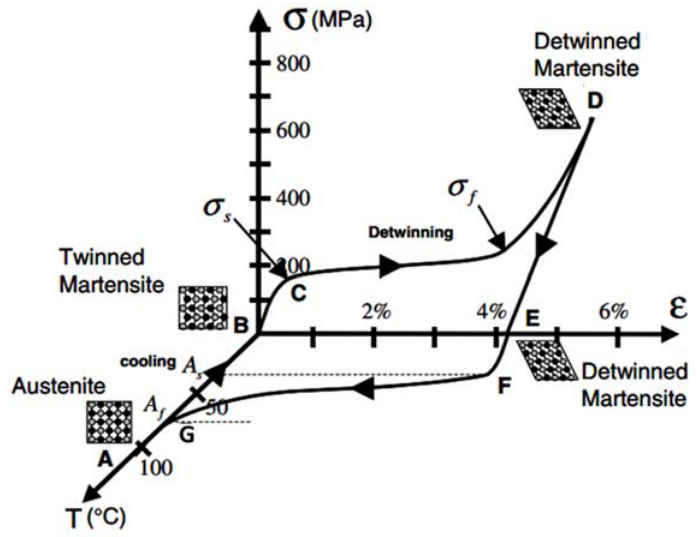
Figure 24. The experimental data in stress-strain-temperature space for a typical NiTi specimen tested under uniaxial loading. Adapted from [188], with permission from © 2018 Springer Nature